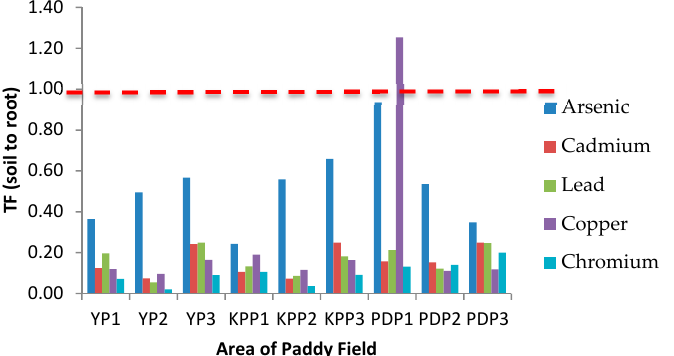
Figure 3. Translocation factor (TF) of studied metals from soil to root (TF Soil ) in areas of Yan, Kubang Pasu, and Pendang. YP1: Yan Plot 1, YP2: Yan Plot 2, YP3: Yan Plot 3, KPP1: Kubang Pasu Plot 1, KPP2: Kubang Pasu Plot 2, KPP3: Kubang Pasu Plot 3, PDP1: Pendang Plot 1, PDP2: Pendang Plot 2, and PDP3: Pendang Plot 3.